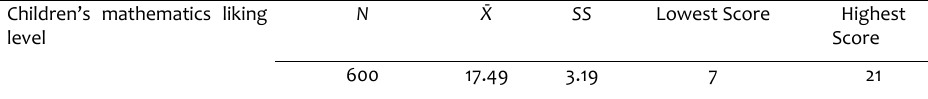
Table 7. Medium, lowest, and highest score distribution of children’s mathematics liking level Children’s mathematics liking level